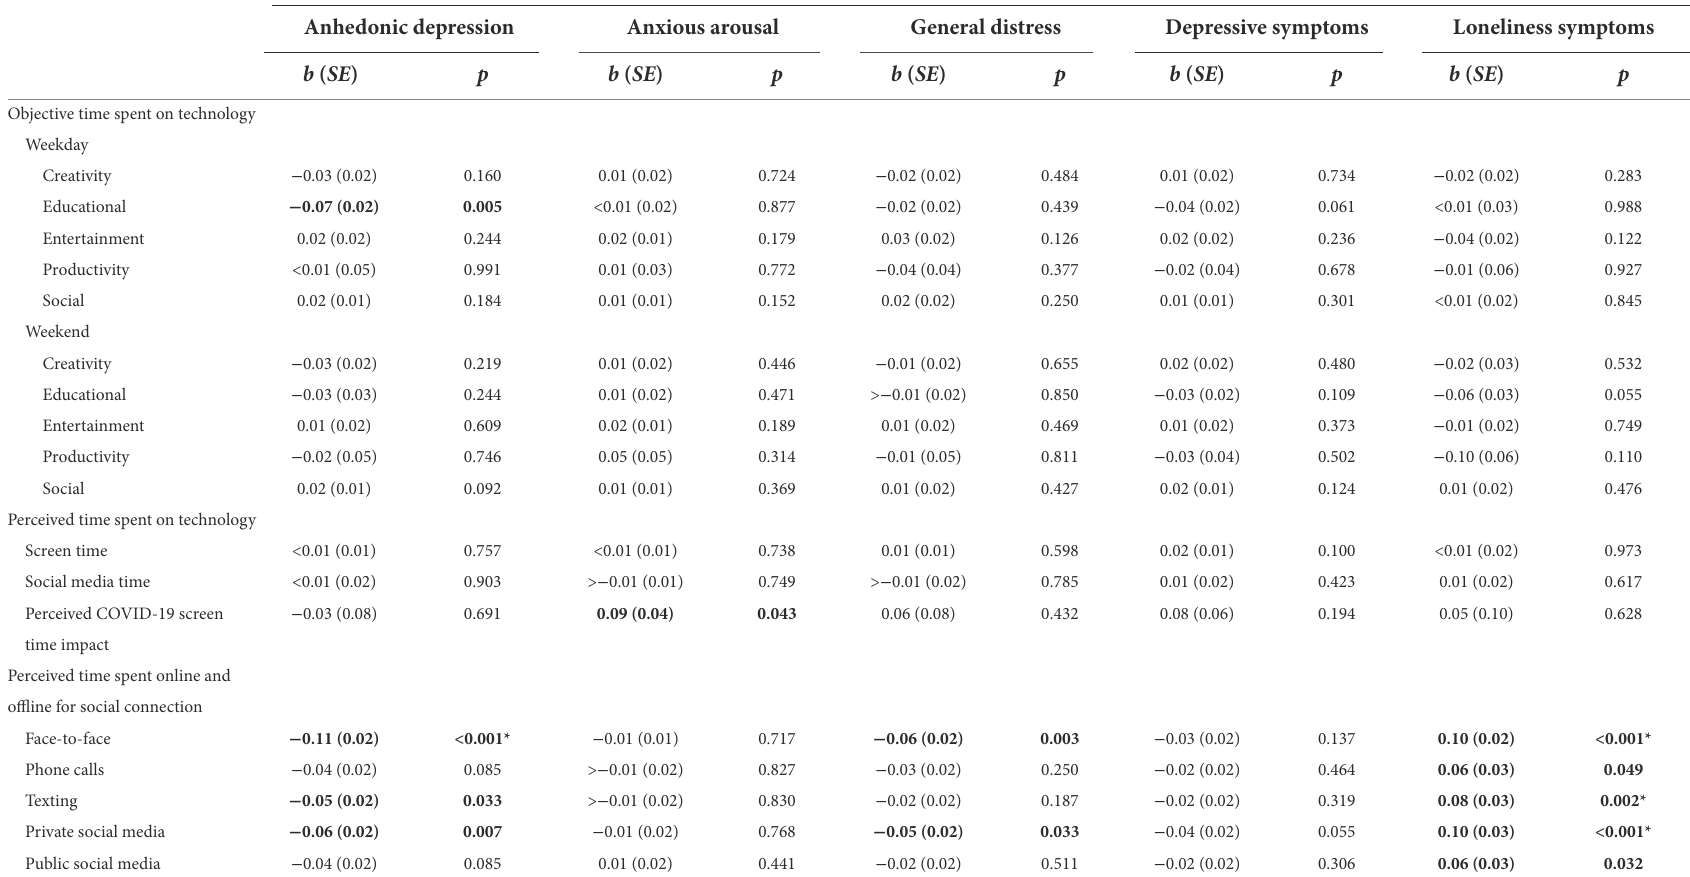
TABLE 2 Direct associations between digital technology engagement and mental